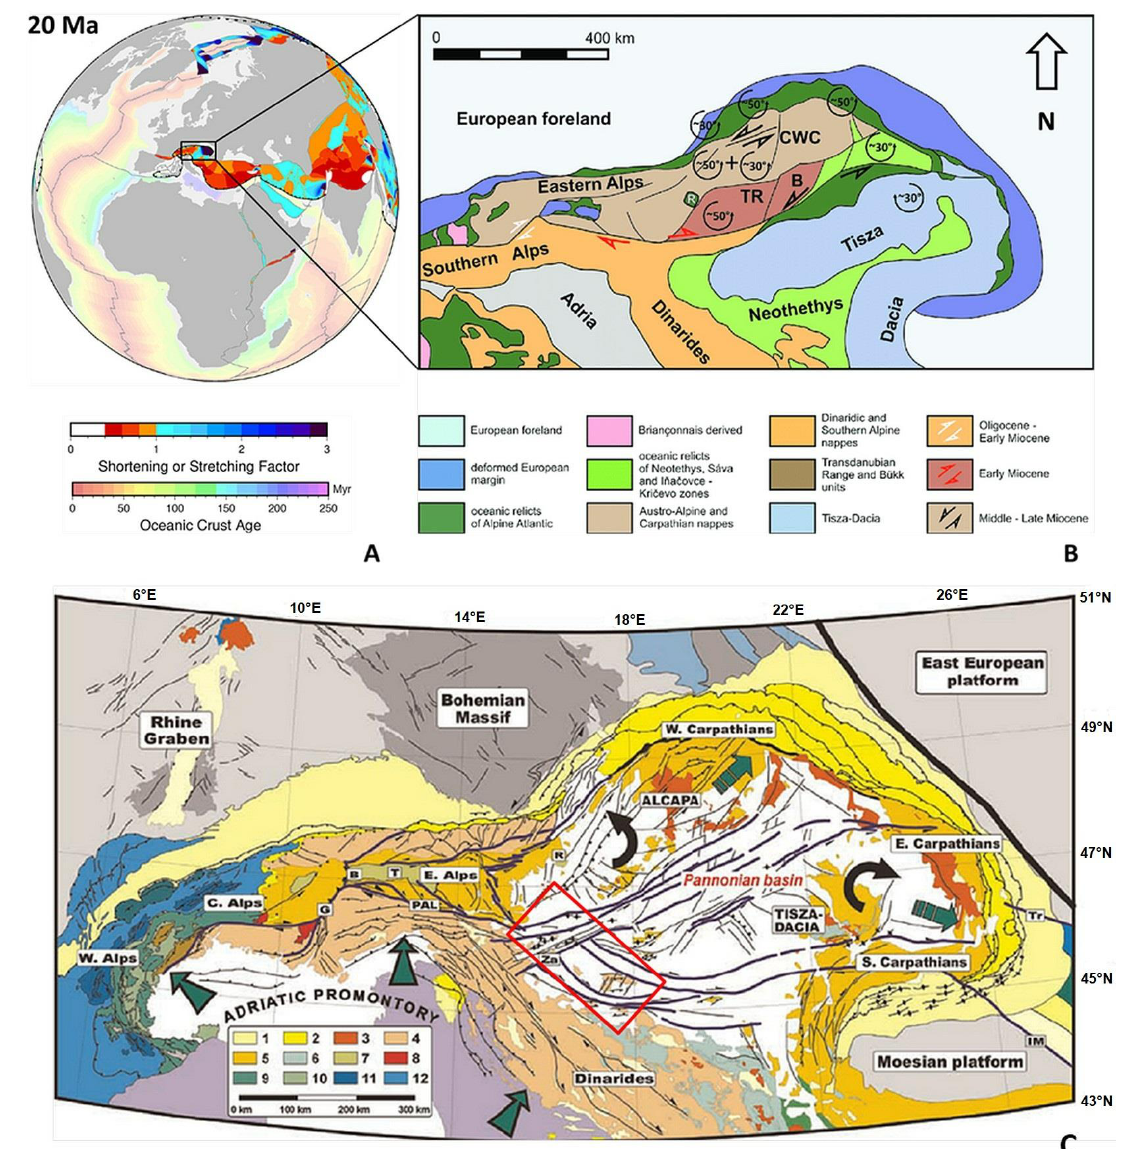
Figure 2. ( A ) Orthographic projection of the Earth before 20 Ma. presenting plate deformations, dom- inantly present in the Peri-Mediterranean region. Continents—medium grey; submerged continental regions—light grey. Oceanic crust age shown in colors. Regions in extension (stretching factor >1)— blue; compressed regions (stretching factor <1)—orange/red colors [29]; ( B ) Tectonic mega-units of the Alpine-Carpathian-Pannonian system with rotation of their individual segments (CWC-Central Western Carpathians; TR-Transdanubian Range; B-Bükk Mountains) [52] ( C ) Simplified Late Cenozoic tectonic map of the Alpine-Carpathian-Pannonian-Dinaric Systems, with formation/deformation data after [53], from [48]. Legend (from [48]): 1, Foreland (molasse) basins; 2, flysch nappes; 3, Neogene volcanic rocks; 4, Southern Alps, Dinarides and Northern Calcareous Alps; 5, pre- Tertiary units of the East Alpine-Carpathian domain and the Jura Mts; 6, Variscan basement of the European Plate, and Dinaric, Vardar and Mures ophiolites; 7, Pieniny Klippen Belt; 8, Oligocene tonalites; 9, Penninic basement; 10, Penninic cover; 11, Helvetic basement; 12, Helvetic cover. T, Tauern Window; R, Rechnitz Window; PAL, Periadriatic Lineament (PAL); G, Giudicarie Fault; Za, Zagreb Fault; B, Brenner Fault; Tr, Trotu Fault; IM, Intramoesian Fault. Croatian Pannonian Basin System (CPBS) is situated within the red rectangular